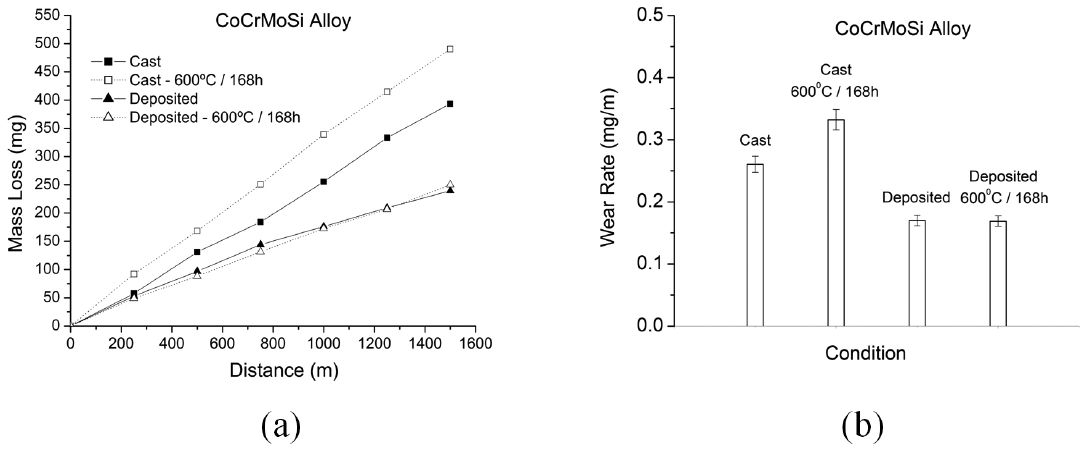
Figure 5. Pin-on-disc wear test: (a) Mass Loss to Distance and (b) Mass Loss